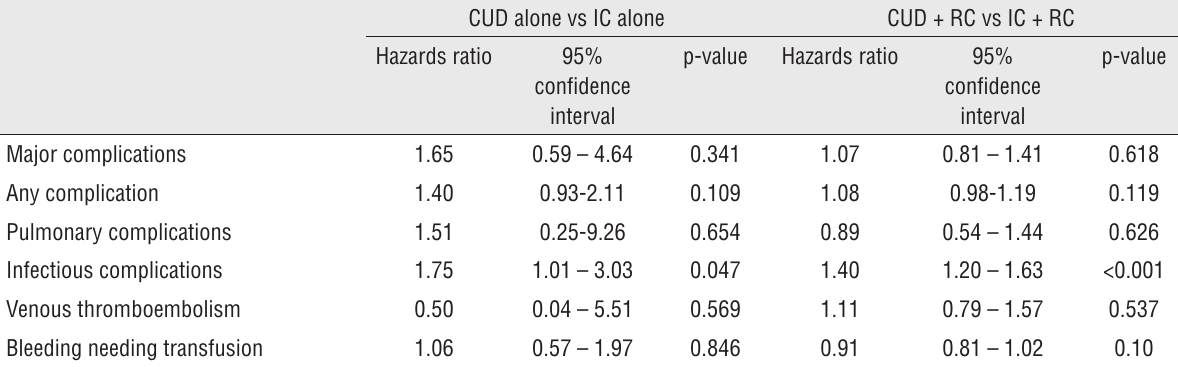
Supplemental Table 6 - Hazards ratios and 95% confidence interval of IC vs CUD, with and without